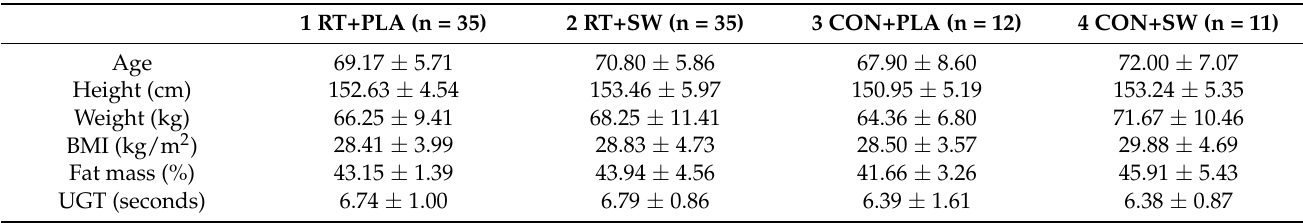
Table 1. Baseline descriptive characteristics of the